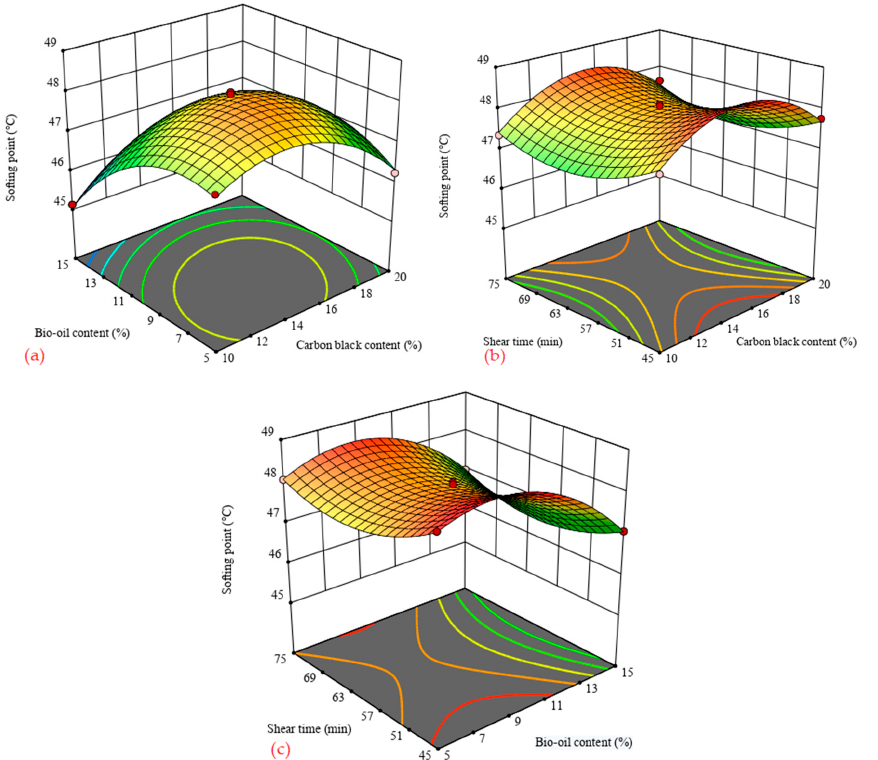
Figure 2. 3D surface of softening point with influence factors. ( a ) shear time = 60 min; ( b ) bio-oil content = 10%; ( c ) carbon black content = 15%.